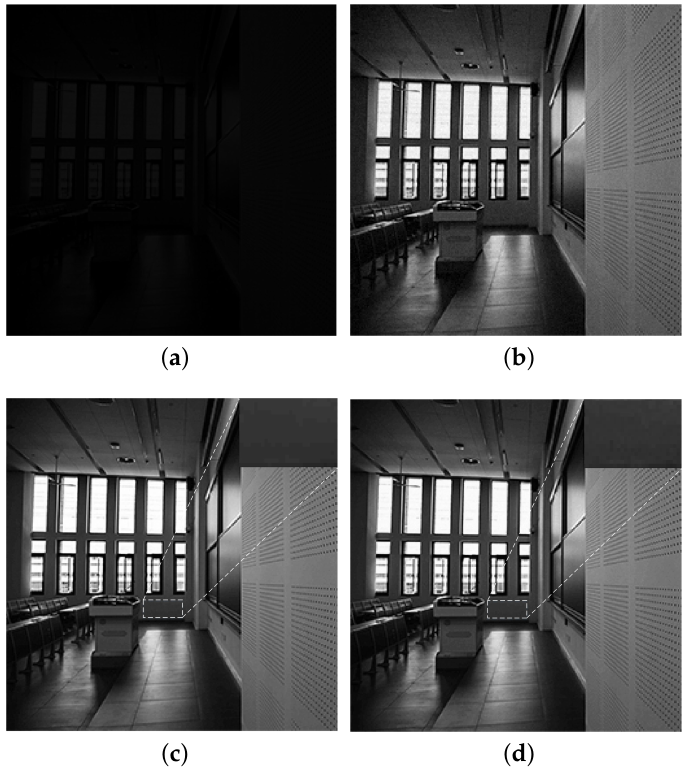
Figure 6. Greyscale images ( a ) Greyscale image with auxiliary noise; ( b ) Amplified image; ( c ) Reconstructed image processed by the traditional accumulation scheme; and ( d ) Reconstructed image processed by the low power accumulation